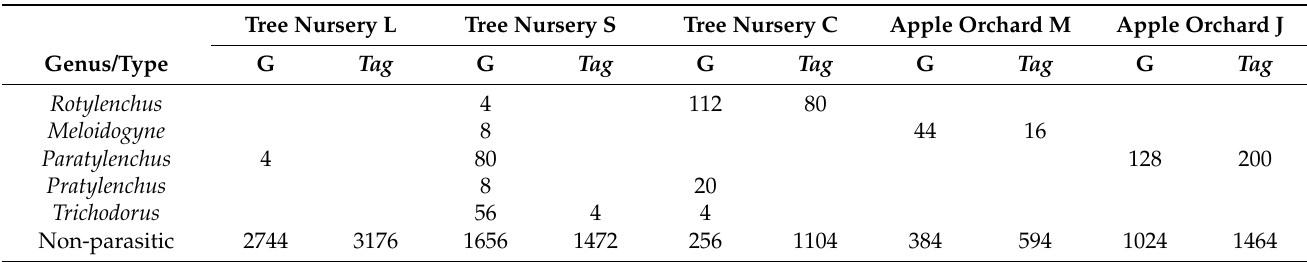
Table 4. Numbers of plant-parasitic and non-parasitic nematodes per 100 mL soil in tree nurseries or apple-growing farms in adjacent plots that were cultivated with Tagetes ( Tag ) or grass (G) before replanting of apple rootstocks. Tree Nursery L Tree Nursery S Tree Nursery